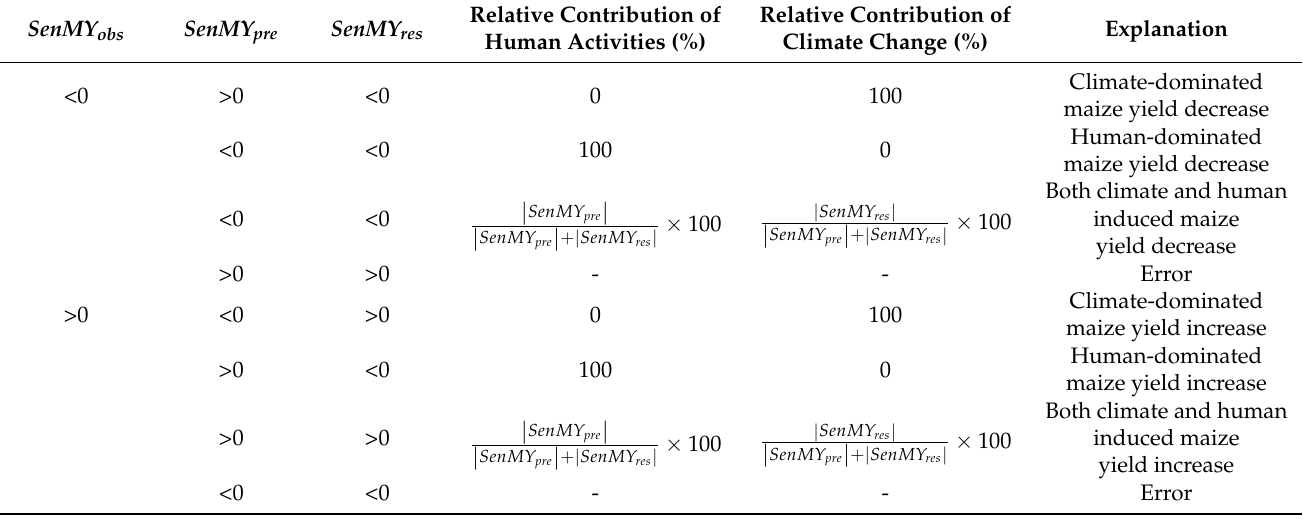
Table A1. Methods for assessing the relative roles of climate changes and human activities in vegetation changes under different